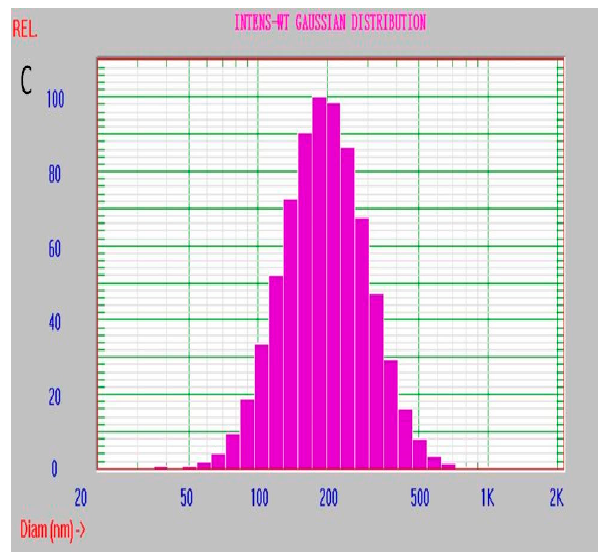
Figure 6. Particle size distribution of the hydrated dPNP at storage day ( A ) 1, ( B ) 7 and ( C ) 15.